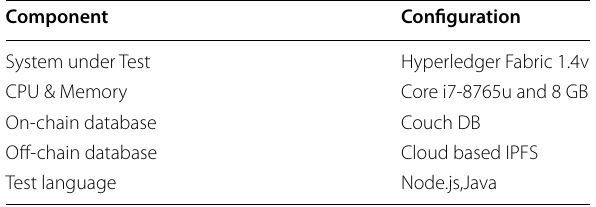
Table 1 Environment configuration